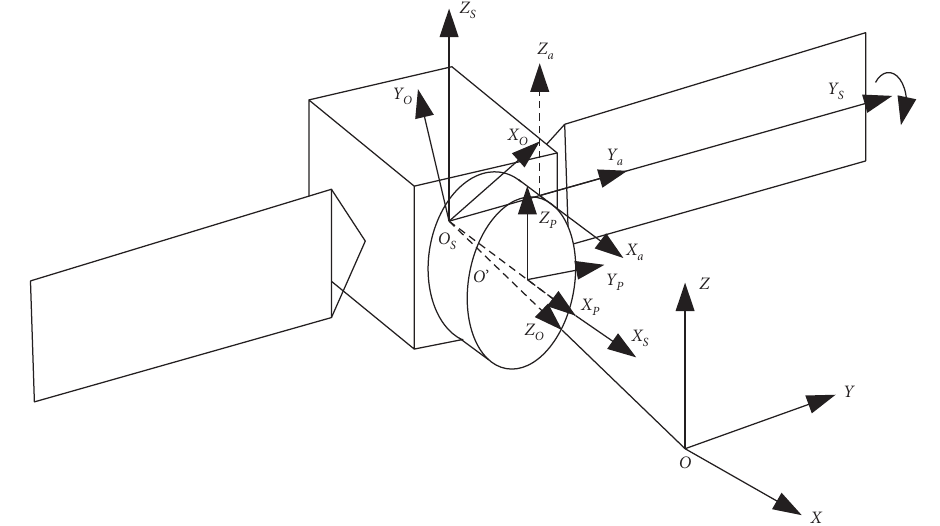
Figure 1: Coordinate system of spacecraft with